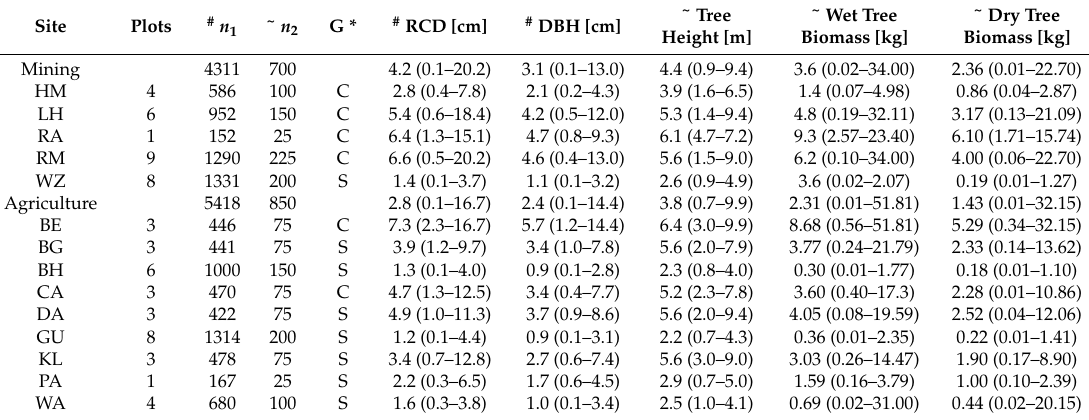
Table 3. Measured and calculated tree variables for each sampled site: growth *, root collar diameter (RCD), diameter at breast height (DBH), tree height, wet tree biomass, and dry tree biomass of